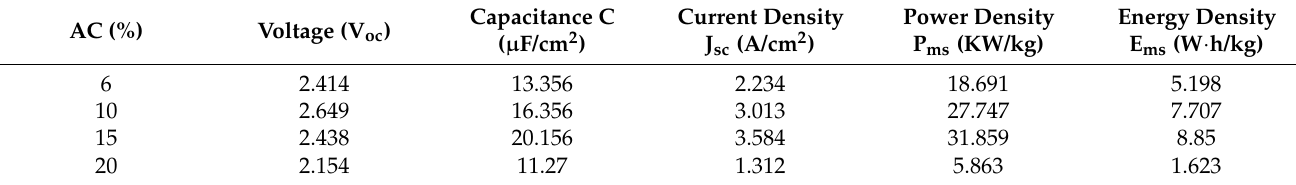
Figure 23. Performance of OSSC for the different % of AC ( a – d ). Table 12. Overall performance of the AC-ZnO/CuO-ER_CF